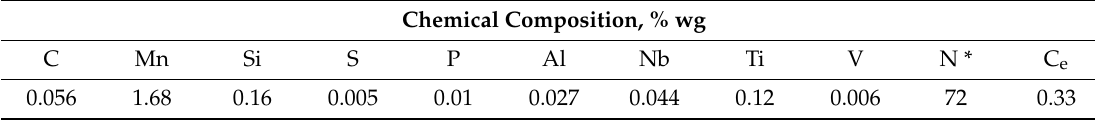
Table 2. Chemical composition of used S700MC steel 10 mm thick